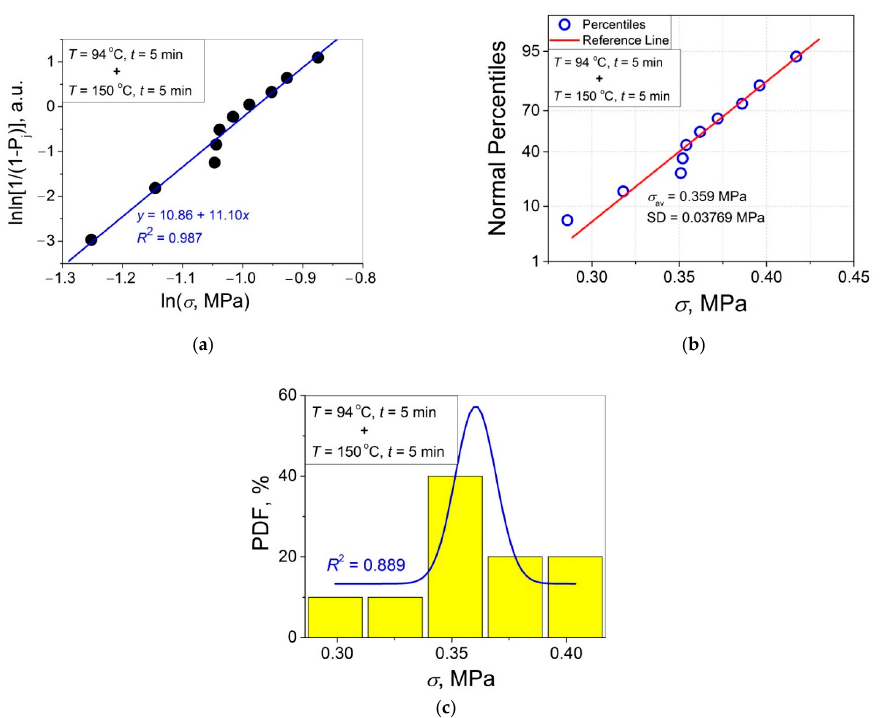
Figure 7. ( a ) Linear regression fit of the lap shear strength σ in Weibull’s coordinates; ( b ) normal probability plot; ( c ) probability density function (PDF) vs. σ fitted with a Gaussian function for an amorphous PET–PET interface self-bonded at T = 94 °C for t = 5 min and at T = 150 °C for t = 5 min.